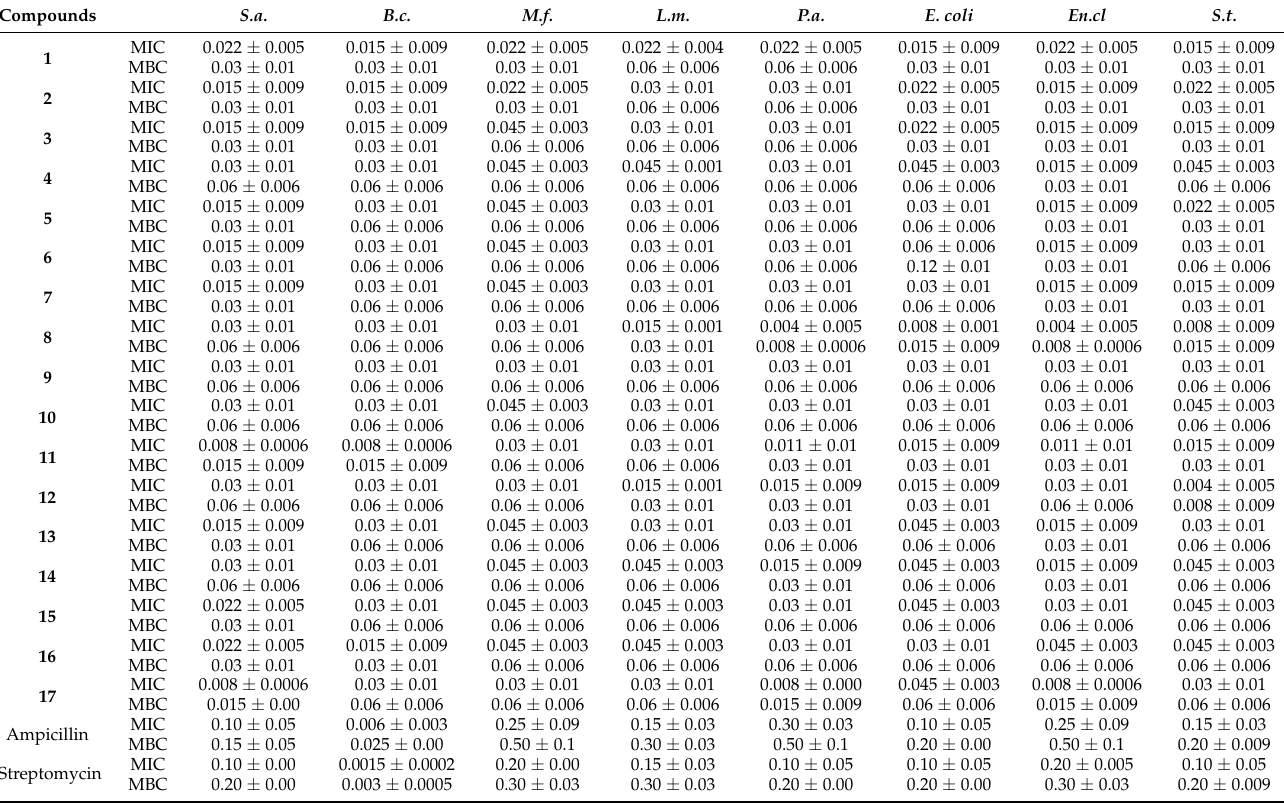
Table 2. Antibacterial activity of target compounds (MIC and MBC in